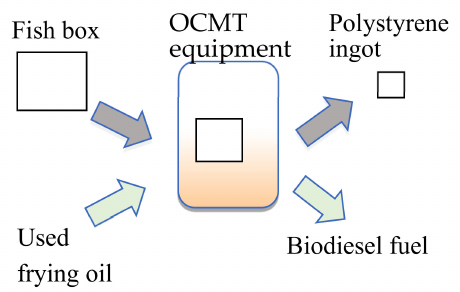
Figure 5. Volume reduction and recycling process of styrofoam using vegetable oil. The deodorized fish boxes are more likely to be recycled into high-grade raw materials, and the vegetable oil used as a solvent can be converted into biodiesel fuel. In the future, it will be possible to construct a closed system that does not generate waste